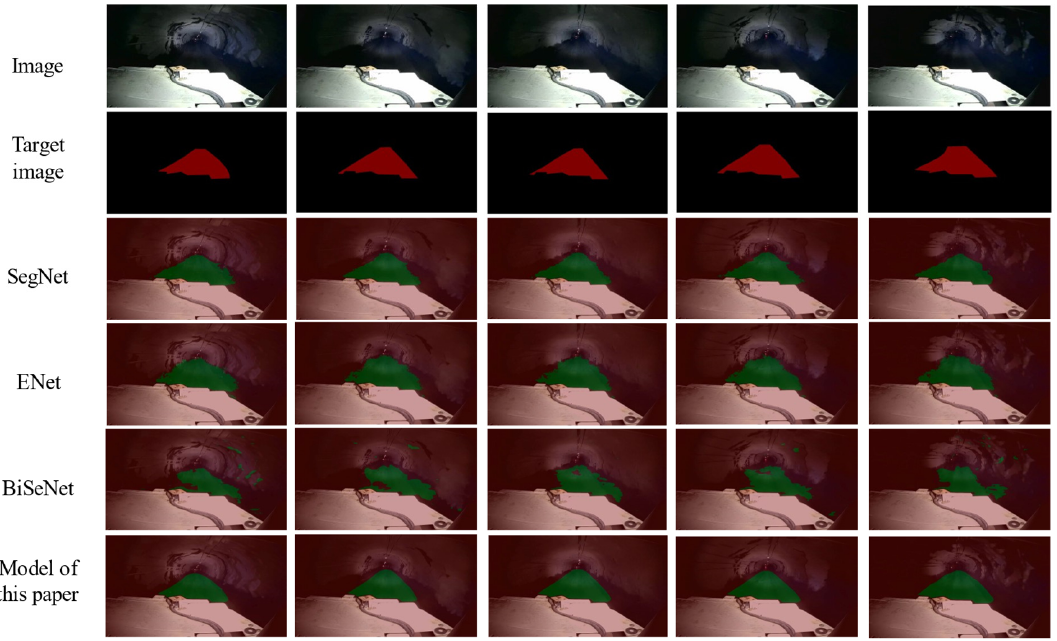
Figure 14. Comparison chart at different time